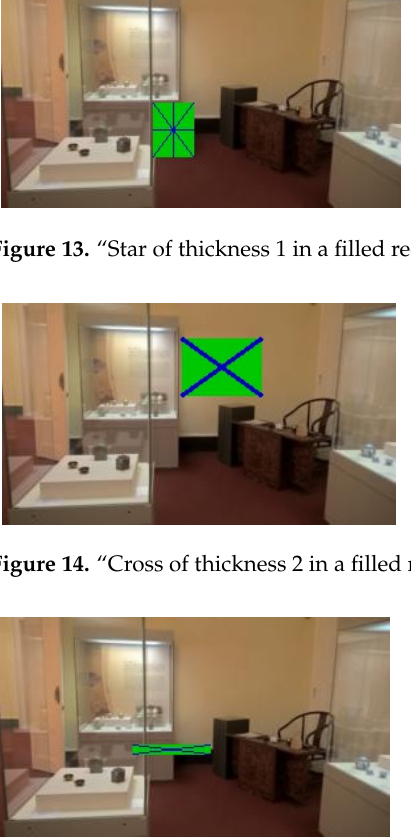
Figure 12. “Star of thickness 2 in a filled rectangle”.